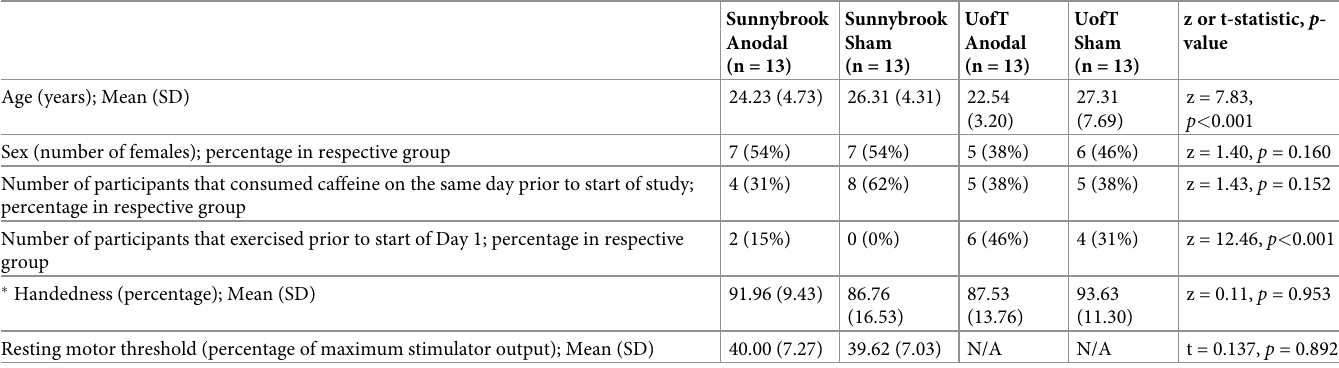
Table 1. Demographic